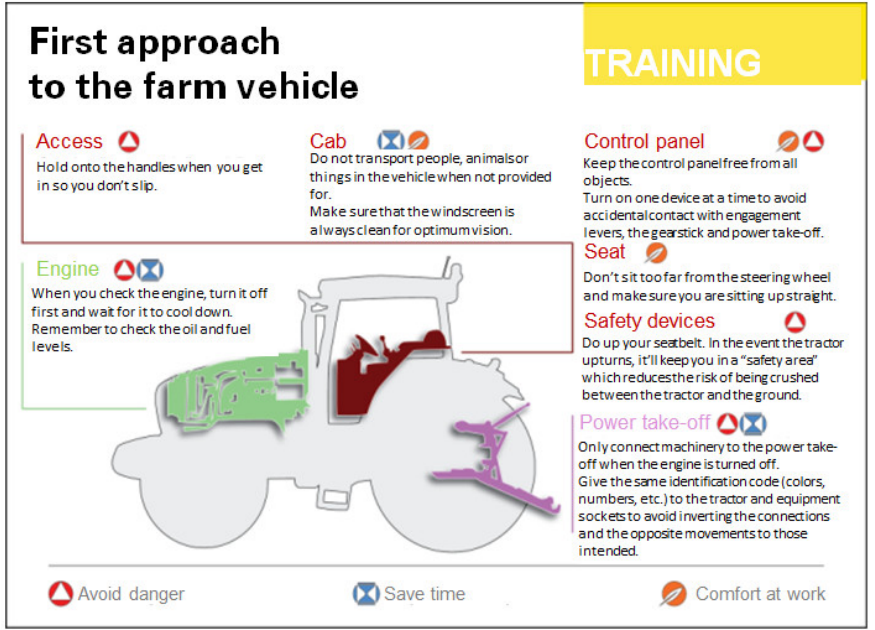
Figure 5. Prototype of manual page setting: example on the driver’s position.